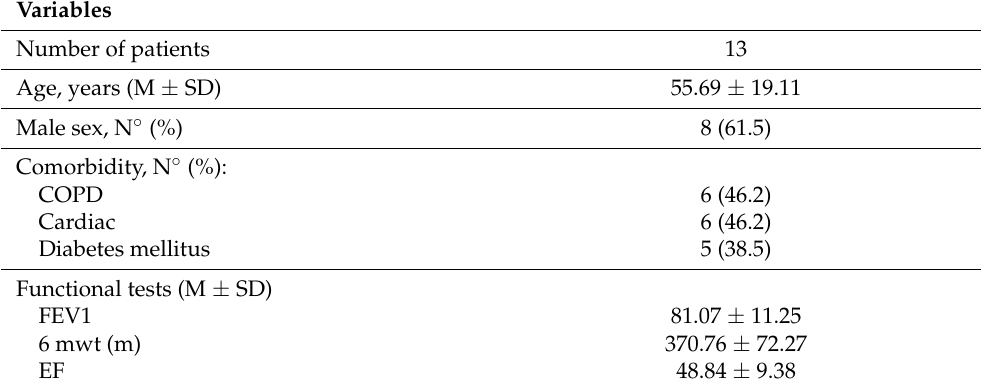
Table 1. Characteristics of the study